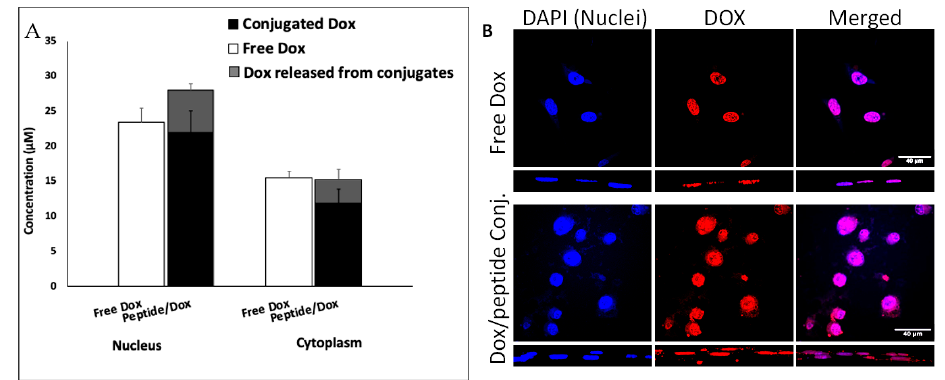
Figure 4. Intracellular tracking of Dox in MDA-MB-231 cells revealed efficient nuclear delivery by [(WR) 8 WK β A]-Dox via quantification by ( A ) HPLC in nuclear and cytoplasmic compartments and by ( B ) confocal microscopy.